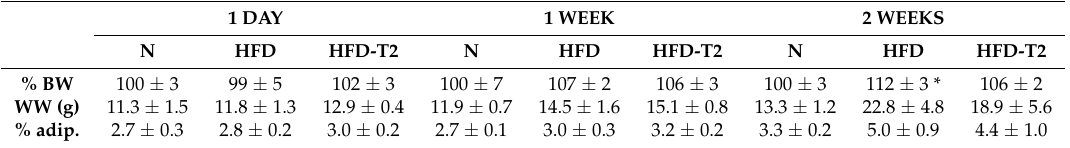
Table 1. Body weight and visceral adipose tissue mass of animals treated as indicated 1